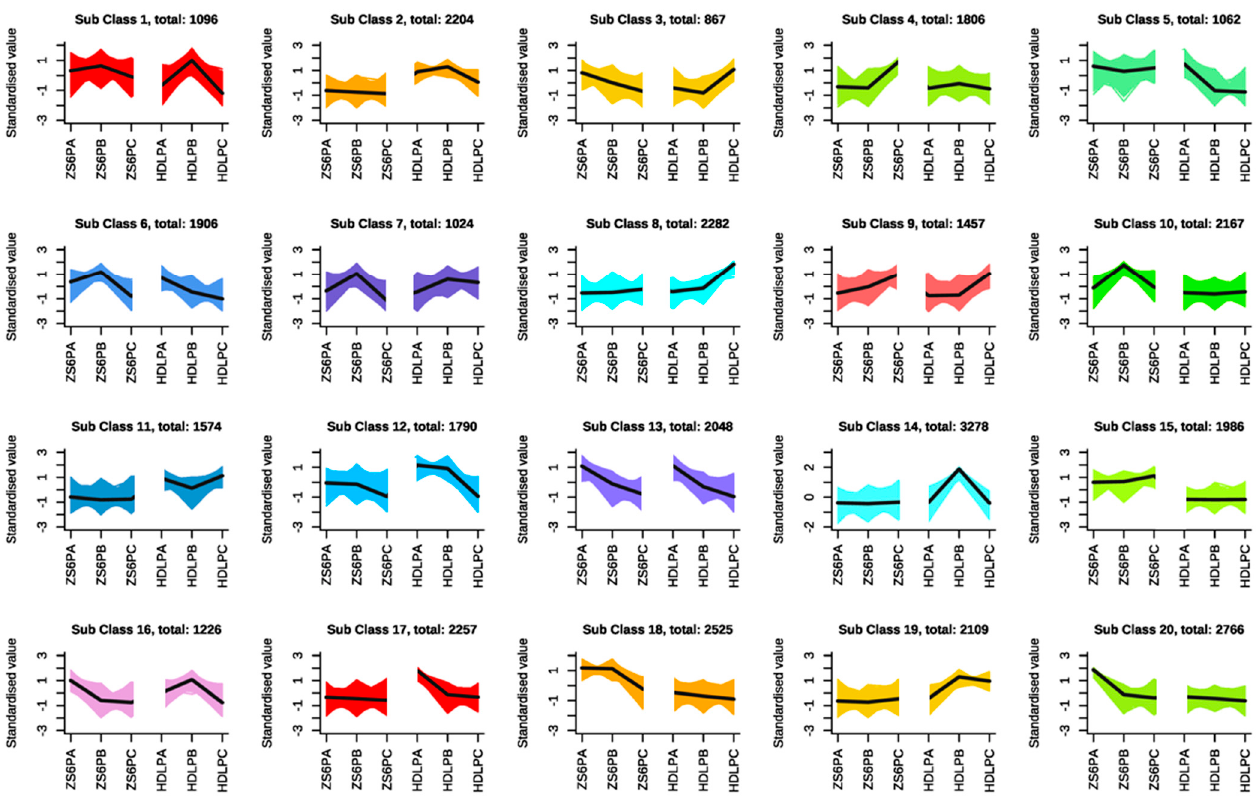
Figure 5. Clustering gene expression profile of two persimmon cultivars fruit peel development.